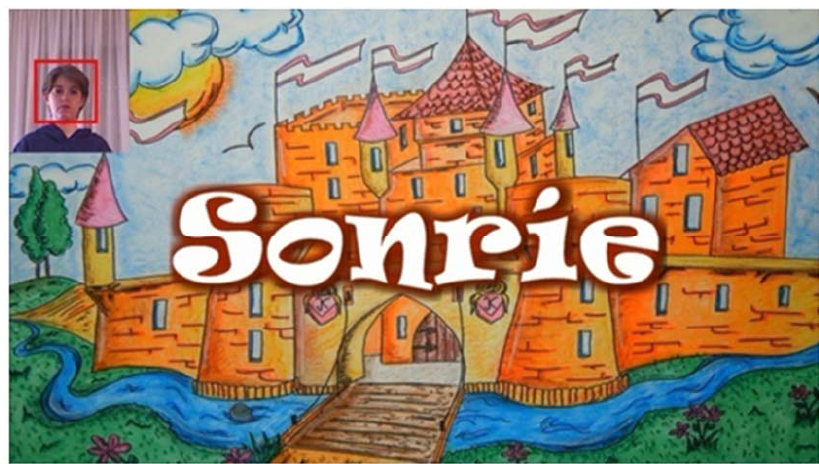
Figure 3. Game theme SONRIE.